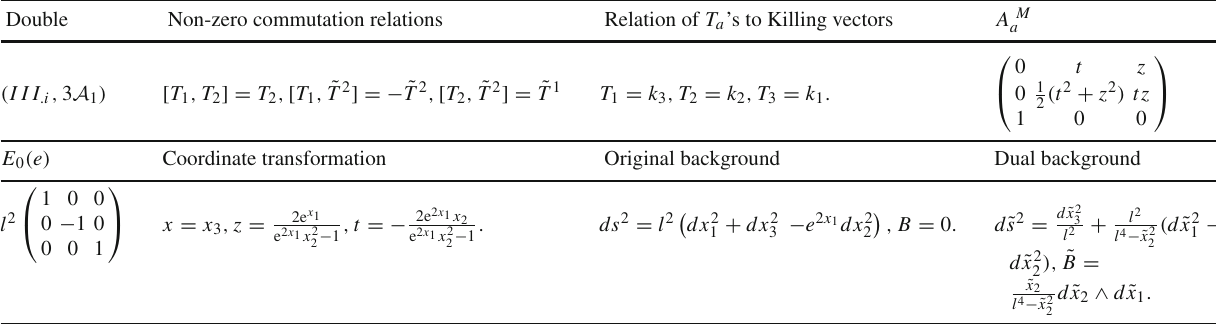
Table 2 The non-Abelian T-duality results of the AdS 2 × S 1 background Double Non-zero commutation relations Relation of T a ’s to Killing vectors